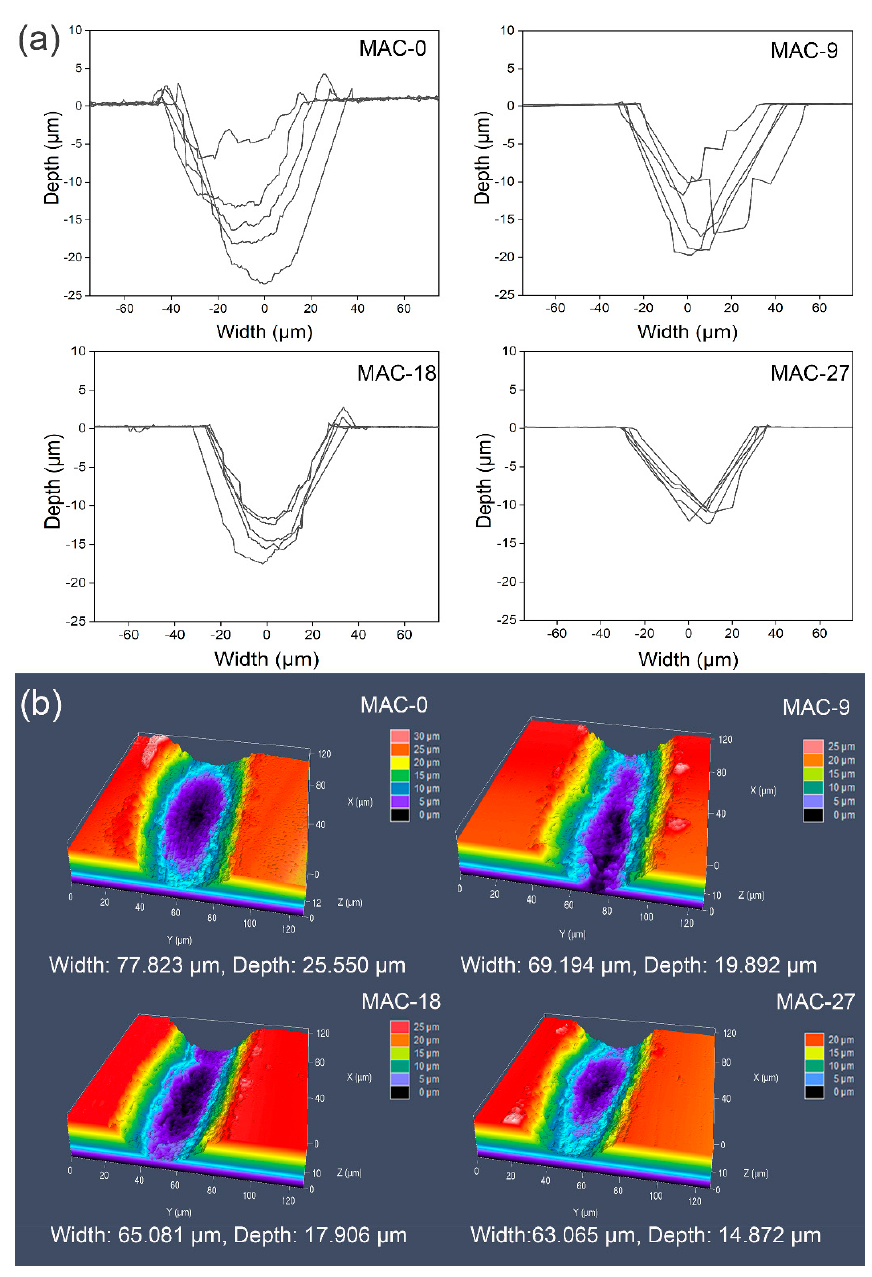
Figure 6. Profiles of the wear scars of the Ti-45Nb samples after fretting: ( a ) two-dimensional morphology and ( b ) three-dimensional morphology.